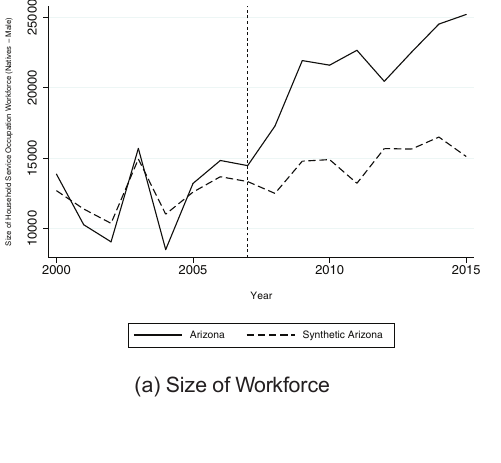
Figure A27 Size of native workforce (male) in household service